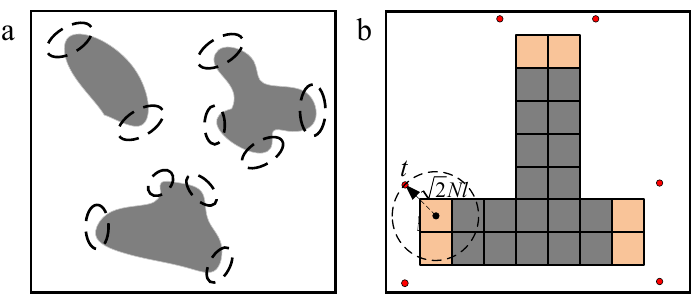
Figure 8. ( a ) The prominent part of the obstacle. ( b ) Sampling of shape points.